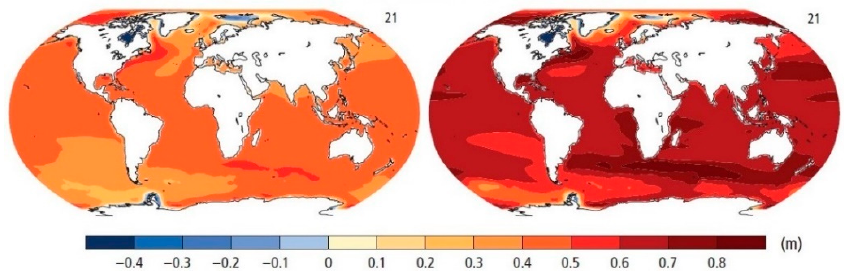
Figure 9. Scenarios for change in sea level for the 2081–2100 period under the RCP2.6 (left) and RCP8.5 (right) (modified after IPCC [2]).